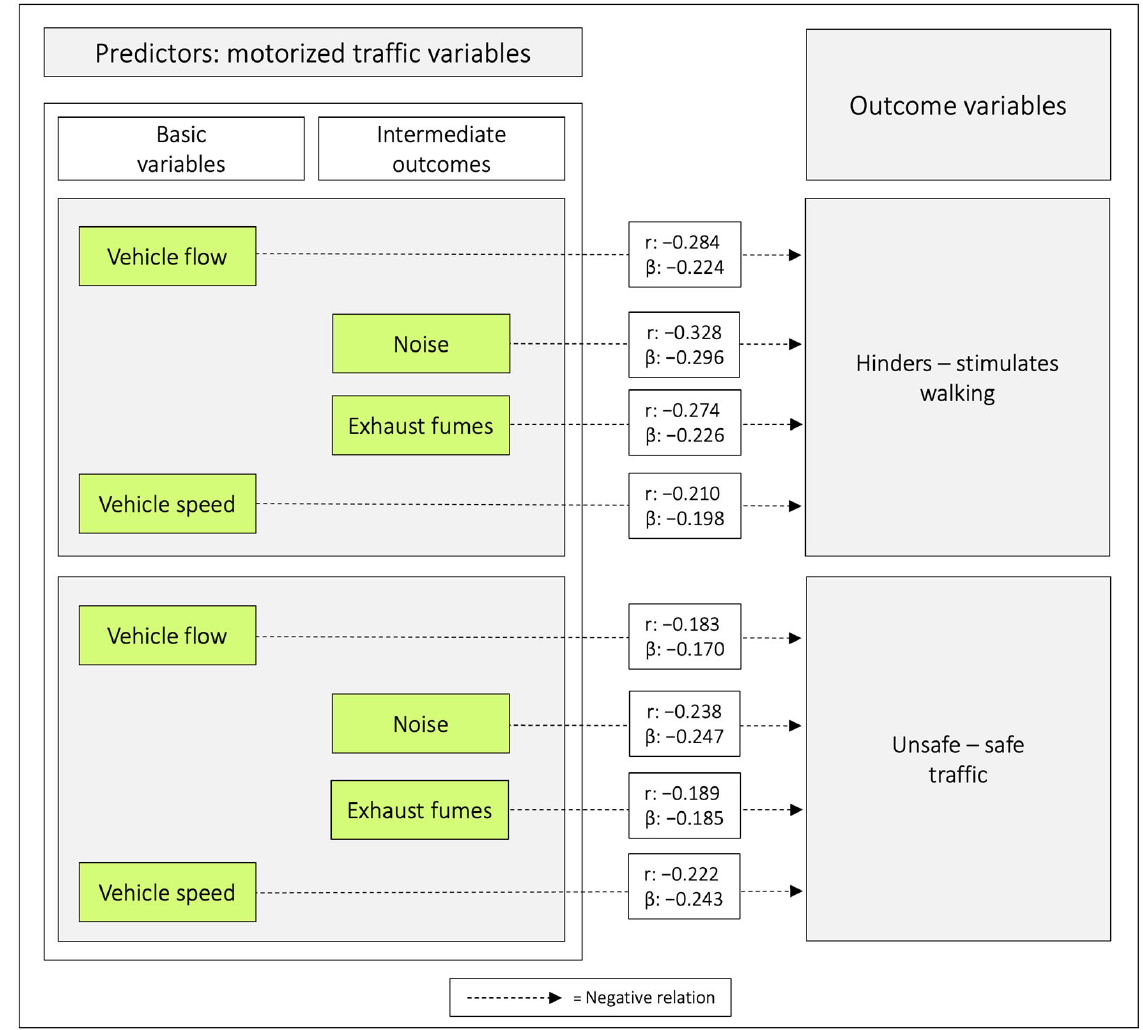
Figure A4. Relations between the individual predictor variables and the outcome variables. Notes: r = Pearson’s correlation coefficient and β = unstandardized beta. The figure is based on Tables 4, A5 and A6.